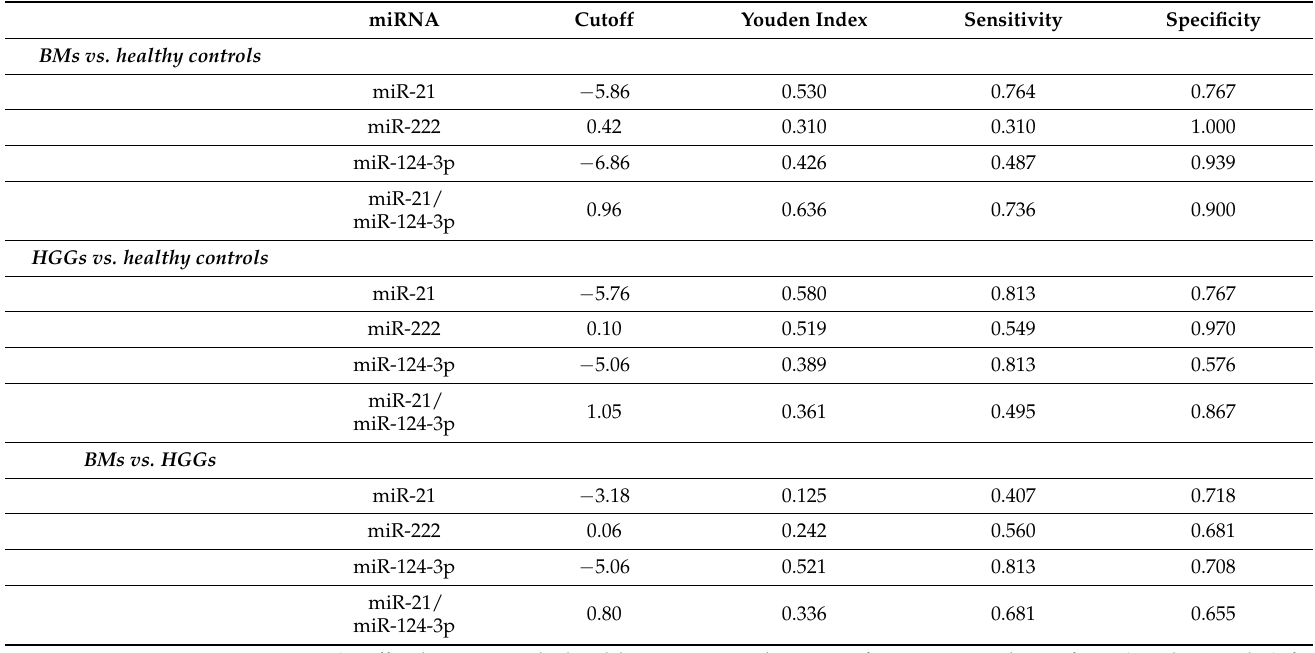
Table 3. Cutoff values for exosomal miRNA expression. miRNA Cutoff Youden Index Sensitivity